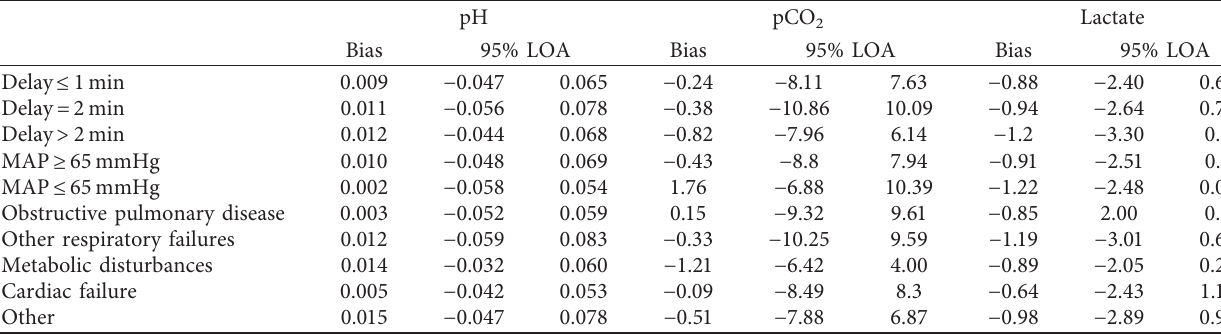
Table 3: Subgroup analysis according to delays in sampling and suspected